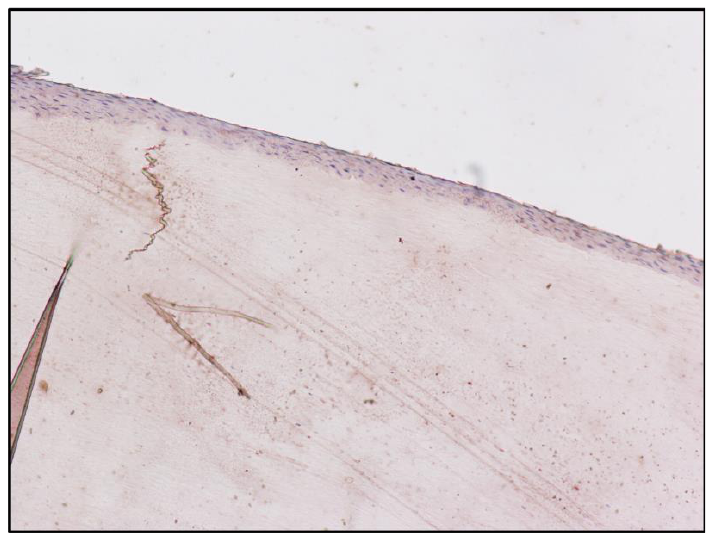
Figure 5. Immunoperoxidase staining for Sheep Anti-Morphine in the fingernail of Subject C, 10× magnification. The pictures show an absence of positivity for morphine in the nail matrix cells. Counterstaining with hematoxylin. Primary Ab: Polyclonal anti-Morphine Antibody produced in Sheep, dil. 1:100. Secondary Ab: Monoclonal Anti-Goat/Sheep IgG-Peroxidase Antibody produced in Mouse, dil. 1:100, original magnification: 10×.